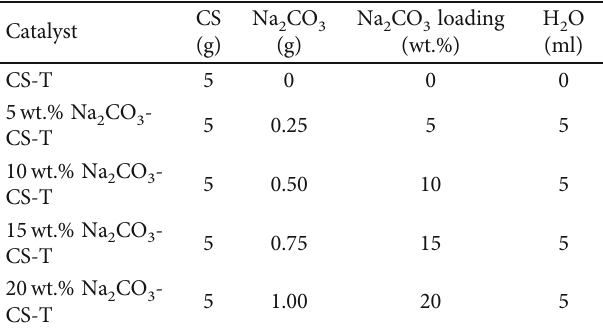
Table 1: The amount of the raw materials in the catalyst